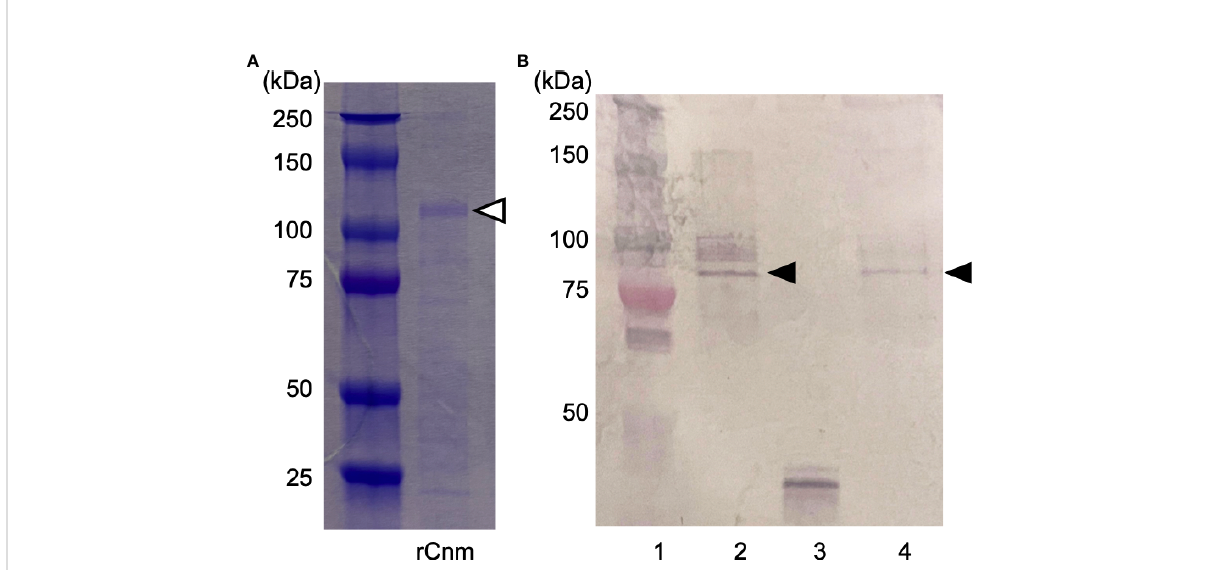
FIGURE 2 Generation and puri fi cation of recombinant Cnm and Cnm antiserum. (A) SDS-PAGE (Coomassie blue staining). The Cnm-glutathione S- transferase fusion protein is indicated with a white arrowhead. (B) Western blot analysis of expression of Cnm (lane 1: protein molecular weight